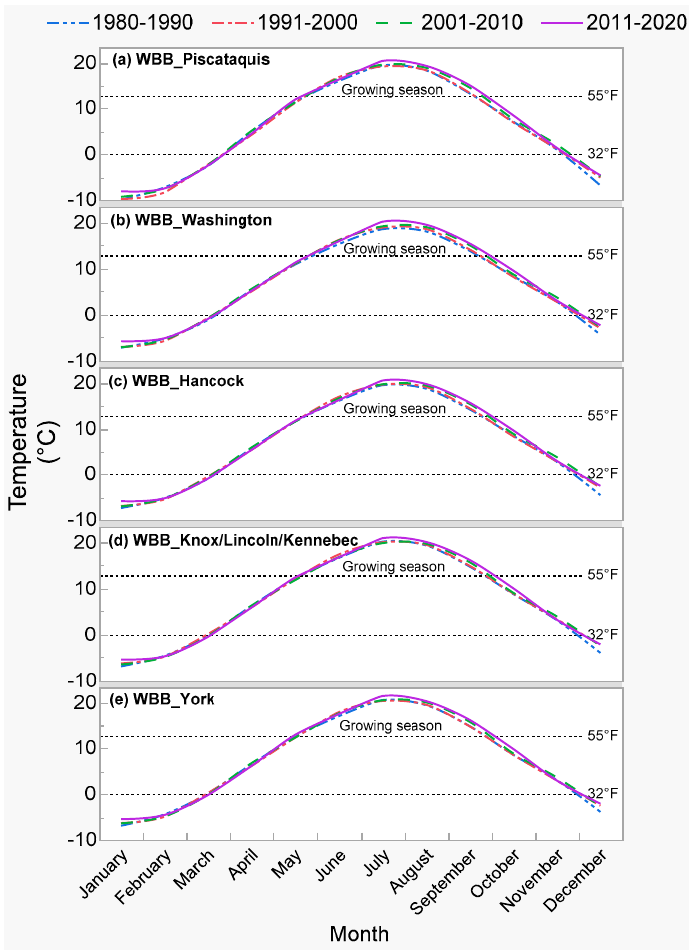
Figure 13. Annual average temperature cycle for the periods of 1980–1990, 1991–2000, 2001–2010, and 2011–2020 (represented by 4 lines of different colors and styles) in the studied wild blueberry barrens (WBBs) in ( a ) Piscataquis, ( b ) Washington, ( c ) Hancock, ( d ) Knox/Lincoln/Kennebec, ( e ) York counties of Maine as shown in Figure 1. Dotted black lines indicate 32 °F (0 °C) and 55 °F (12.8 °C). Approximate last spring frost and first fall frost dates based on the 32°F (0 °C) line, and growing season period based on the 55°F (12.8 °C) line, are further detailed in Table 3. Table 2. Correlation analysis of the increases in climate variables (increase in Tmax, Tmin, Tavg, Ptotal, and SWE) with the geographic factors (latitude, longitude, and distance from the coast) for the studied wild blueberry barrens of Maine (shown in Figure 1) during different seasons at the significance level of p < 0.05 *, p < 0.01 **, and p < 0.001 ***.